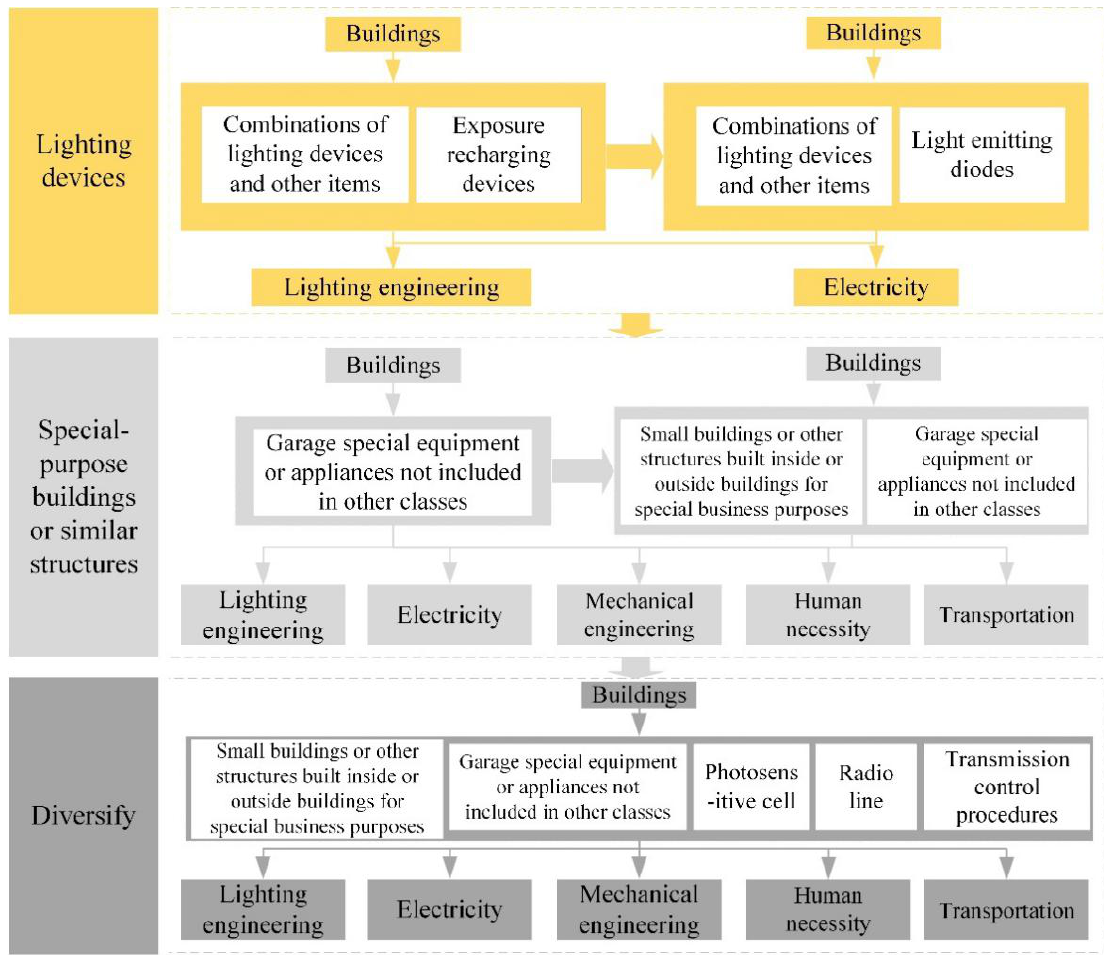
Figure 12. Evolution of key technologies for innovation in the digital construction industry (2016–2020).